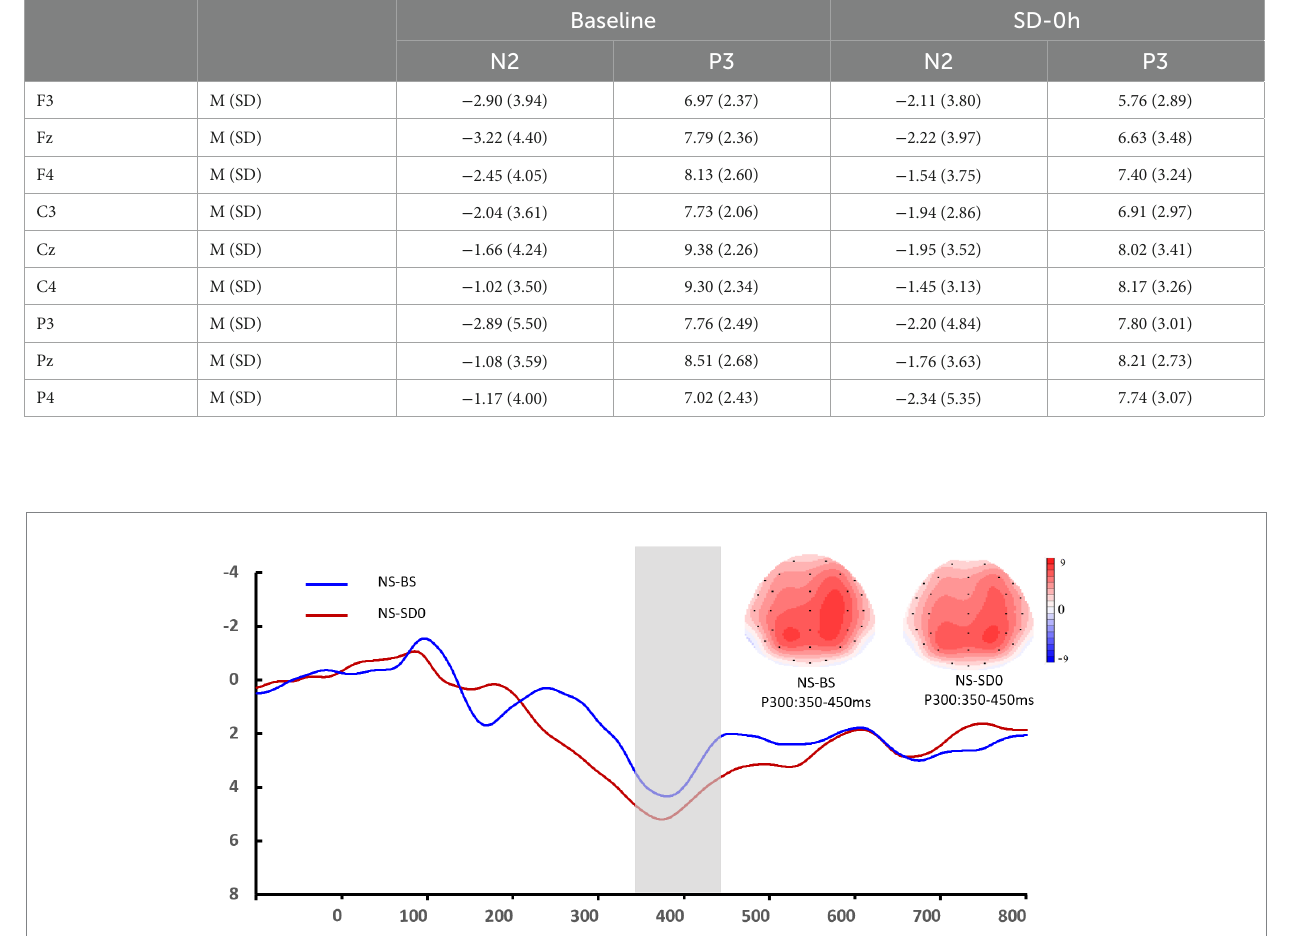
FIGURE 5 Grand mean amplitude of the P3 component in the nocturnal sleep (NS) group at the baseline state (BS) and after 0 h of sleep deprivation (SD0). Averaged data from the F3, Fz, F4, C3, Cz, C4, P3, Pz, and P4 electrodes are shown. The topographies correspond to average activity in the time windows (350–450 ms, indicated by the gray bar) around the local peaks.